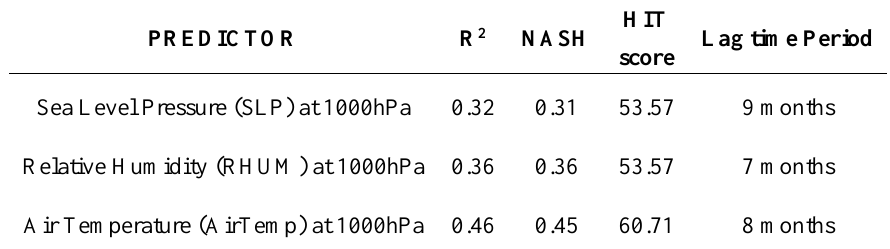
Table 4. Seasonal rainfall forecast model skills using non-linear principal component analysis (NLPCA).